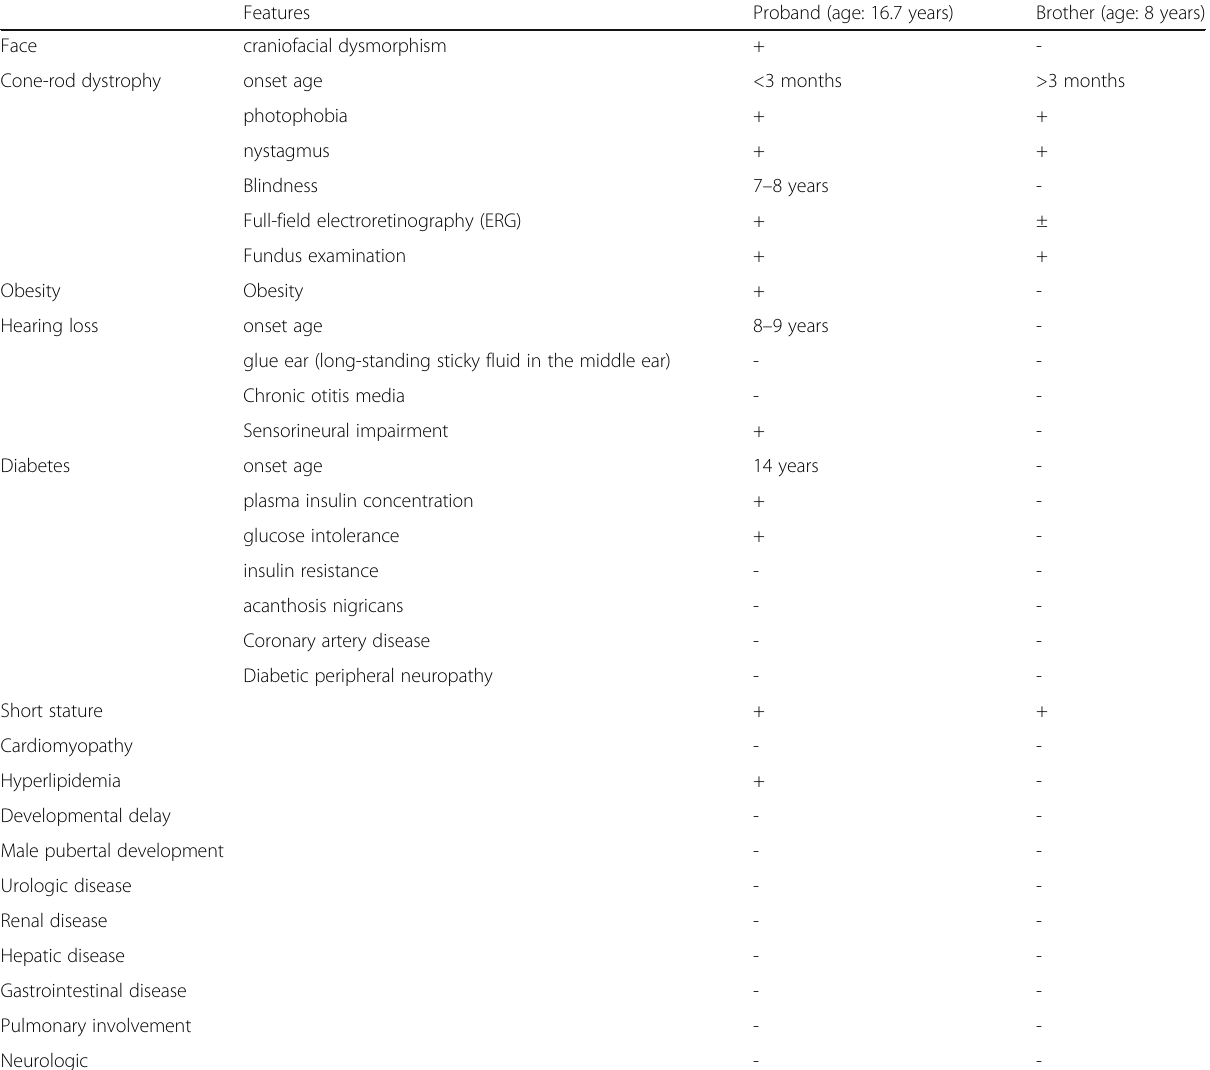
Table 1 Medical history and clinical features in the proband and his brother